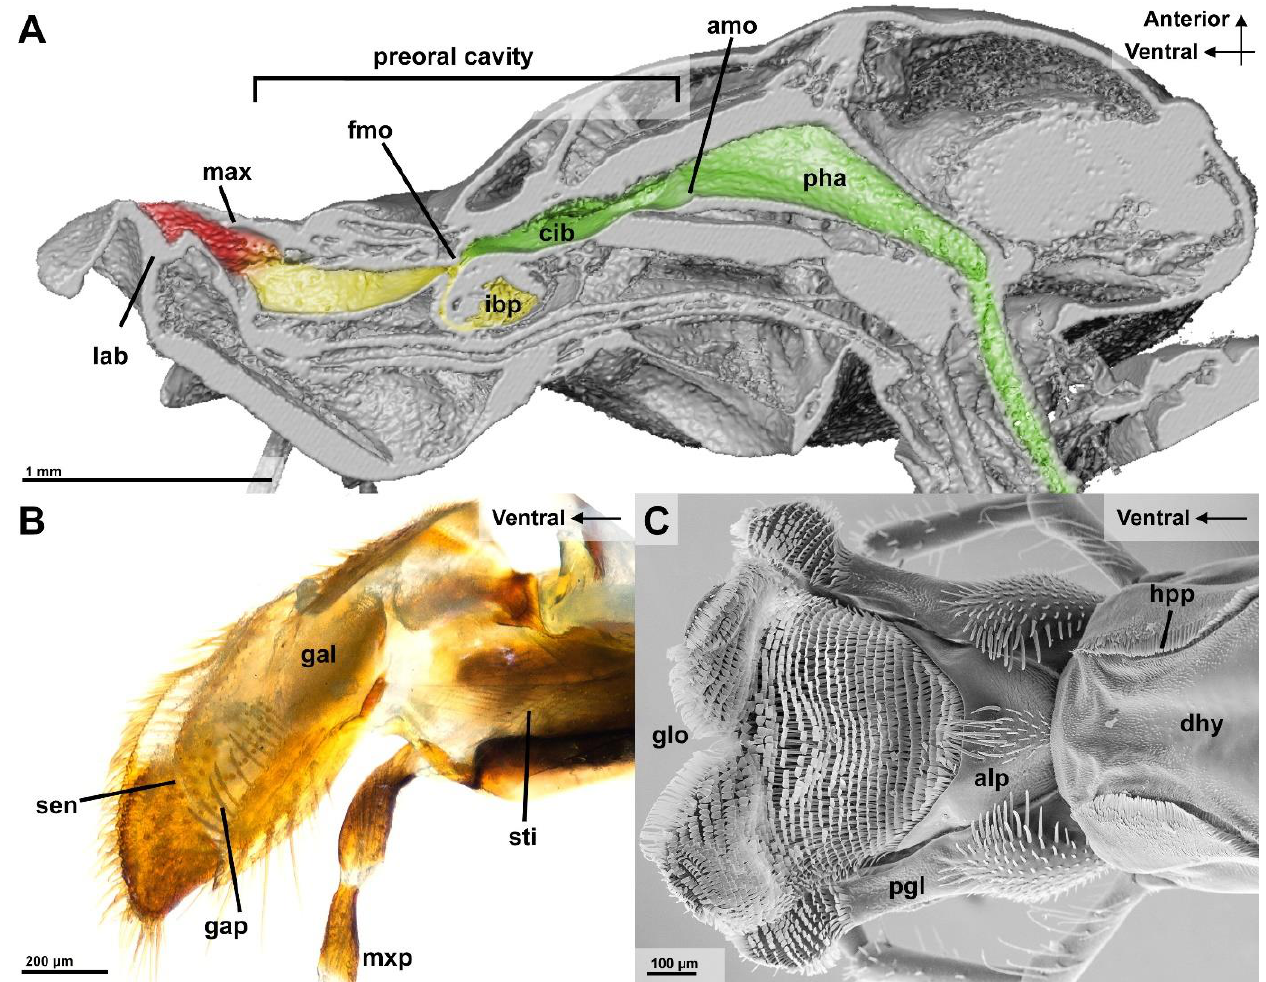
Figure 4. Stages of filtration by the mouthparts and preoral cavity of Vespula germanica . ( A ) Surface render of µCT, cut sagittally with the path of liquid colored; (red): unfiltered liquid; (yellow): sizes >212 µm filtered; (green): sizes >152 µm filtered. ( B ) Surface detail of the right distal maxillar parts from a medial view (light microscopy). ( C ) The surface of the labium in a dorsal view (SEM). [Ab- breviations: alp: anterior ligula plate, amo: anatomical mouth opening, cib: cibarium, dhy: dorsal